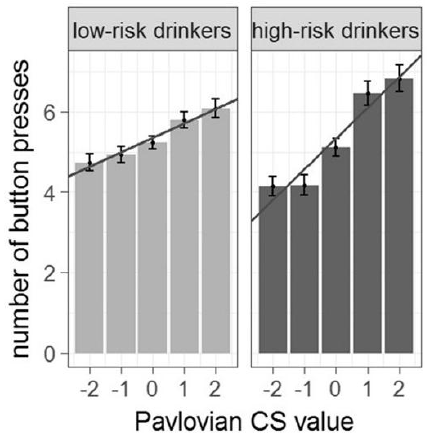
Figure 3. Behavioral PIT e ff ect in low-versus high-risk drinkers ( n = 191). Number of button presses for each Pavlovian background condition. The behavioral PIT e ff ect is stronger in high-risk drinkers (as indicated by a steeper group regression slope).